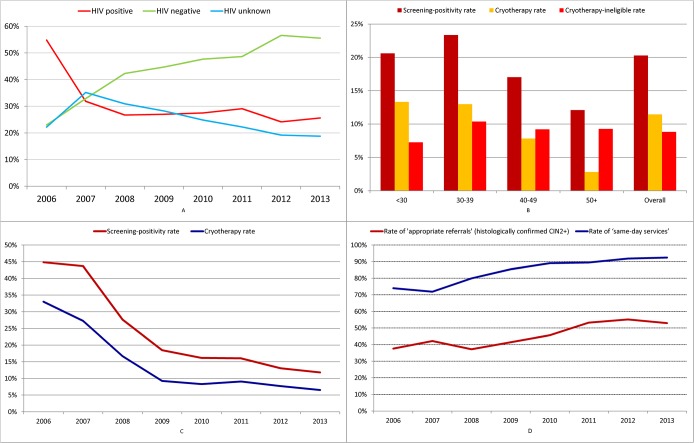
Program process and outcome indicators of the Cervical Cancer Prevention Program in Zambia (CCPPZ).Panel A (Top, left): Trends in HIV status of screened women over the calendar years 2006–2013. Panel B (Bottom, left): Rates of screening positivity, cryotherapy eligibility and cryotherapy-ineligiblity by age categories and overall. Panel C (Bottom, right): Trends in rates of screening positivity and cryotherapy rates over calendar years 2006–2013. Panel D (Top, right): Trends in rates of ‘same day-services’ and rates of ‘appropriate referral’ over calender years 2006–2013.